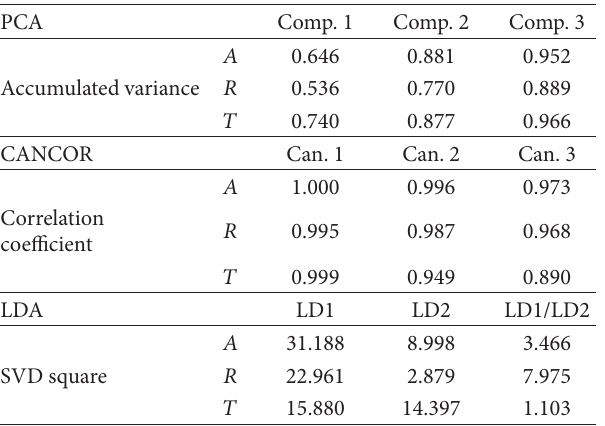
T 7: PCA: Proportion of accumulated variance of the �rst